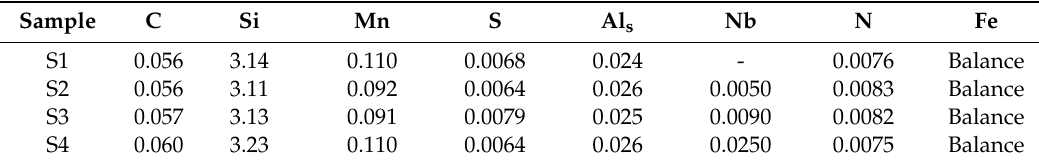
Table 1. Chemical compositions of tested silicon steel